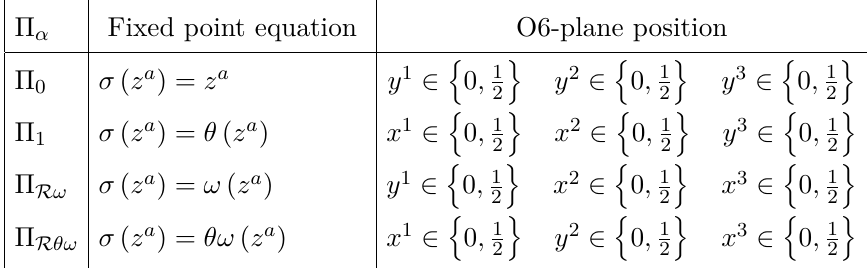
Table 1. O6-planes in T 6 / Z 2 × Z 2